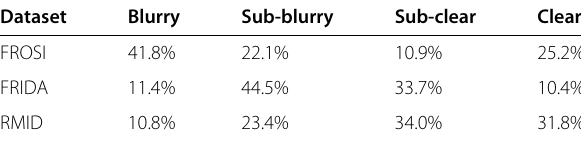
Table 1 Three benchmark imagesets used in our experiment Dataset